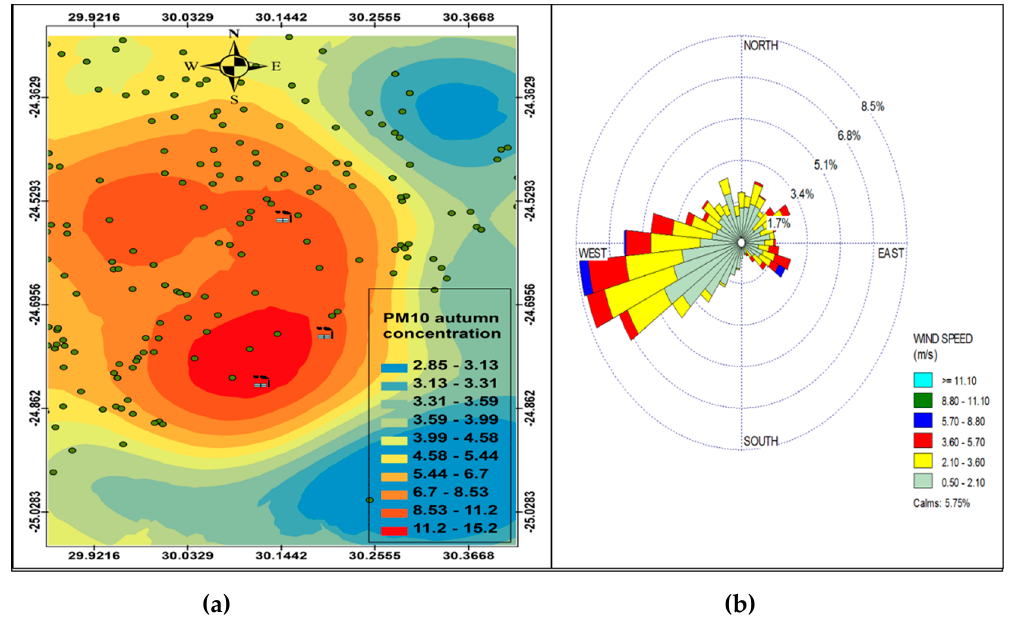
Figure 6. Autumn variation in PM 10 ( µ g.cm − 3 ) ambient concentration ( a ) and wind roses ( b ).